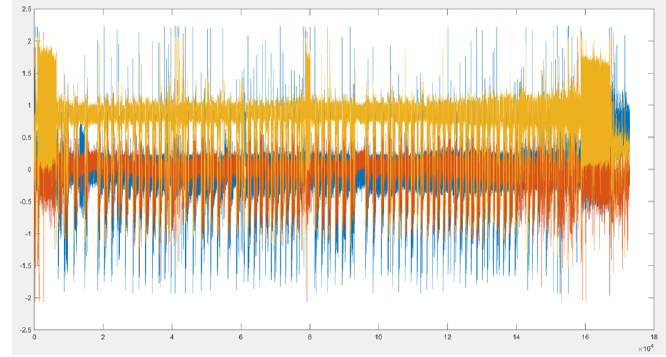
Figure 5. Line chart of the raw accelerometer data (Multivariate time-series